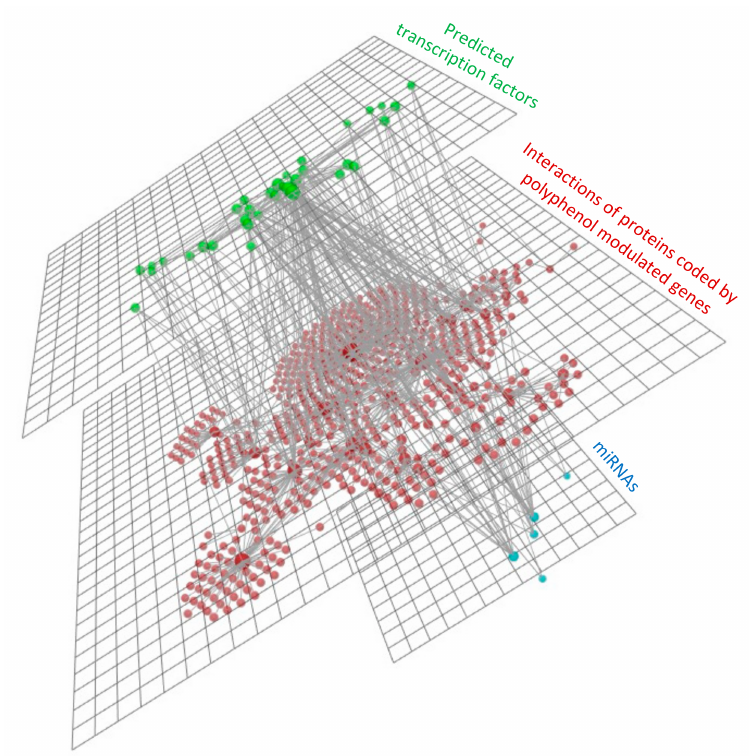
Figure 10. 3D-layer presentation of interactions of proteins that are coded by polyphenol modulated genes (in red color), polyphenol modulated miRNAs (in blue color), and the predicted transcription factors (in green